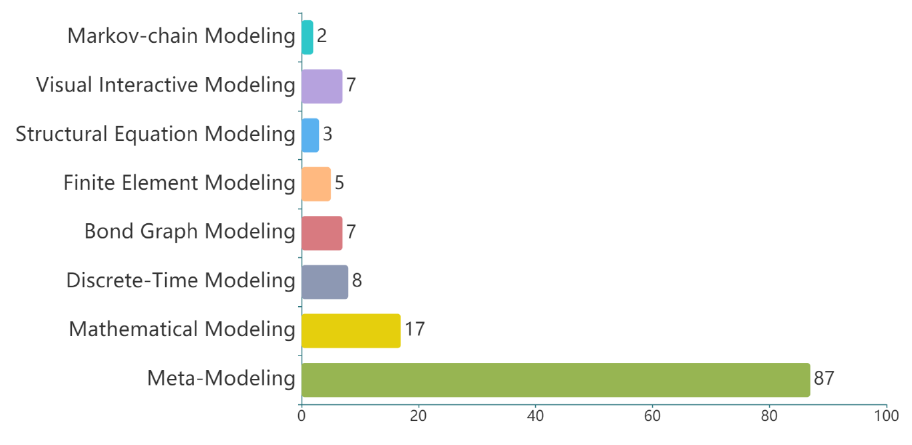
Figure 10. Modeling methods used in the studies.